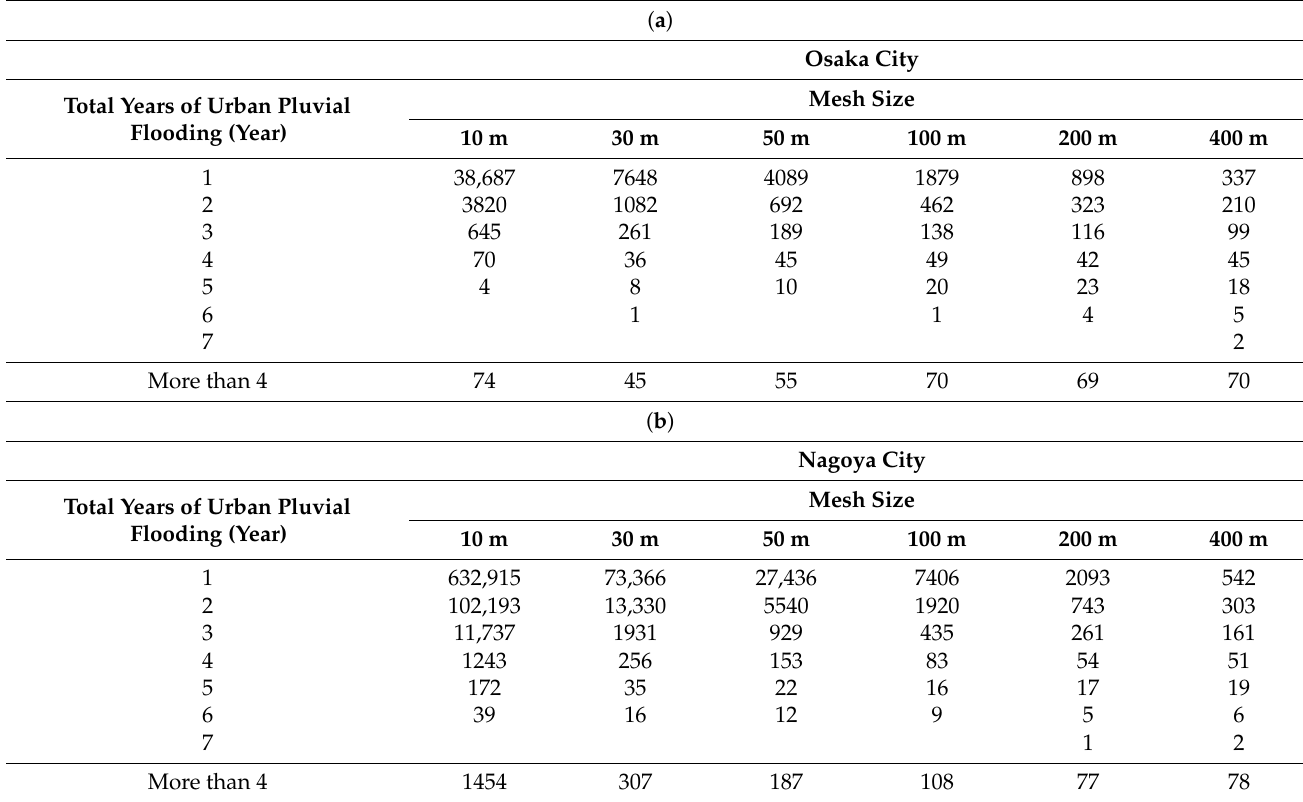
Table 4. ( a ) The relationship between the total years of urban pluvial flooding and the number of urban pluvial flooding areas in the raster data for each mesh size in Osaka City. ( b ) The relationship between the total years of urban pluvial flooding and the number of urban pluvial flooding areas in the raster data for each mesh size in Nagoya City. ( a ) Osaka